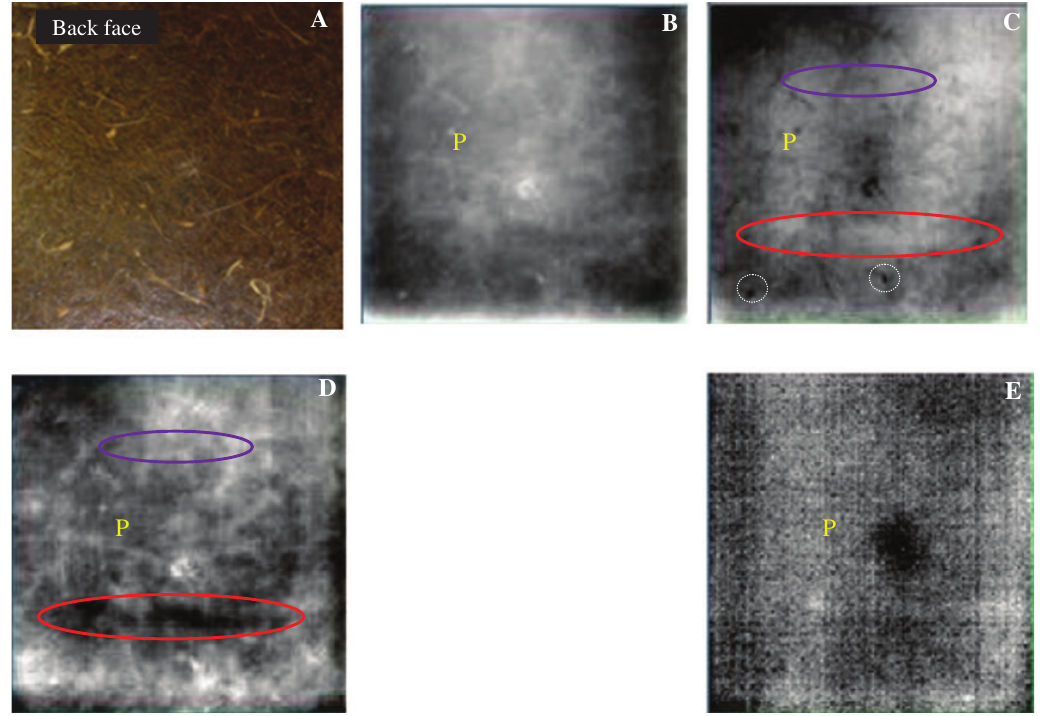
, (C) EOF , (D) EOF , (E) EOF 3 4 6 14